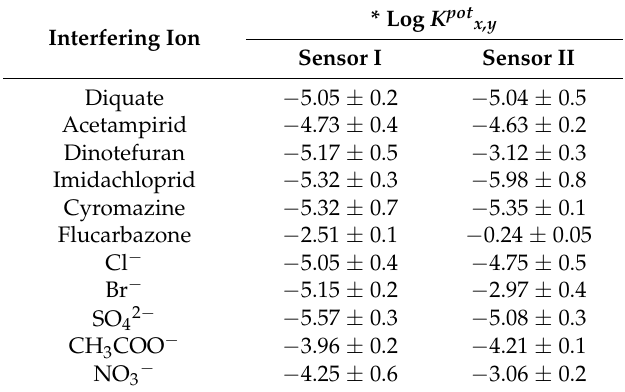
Table 1. Potentiometric selectivity coefficients, log K pot